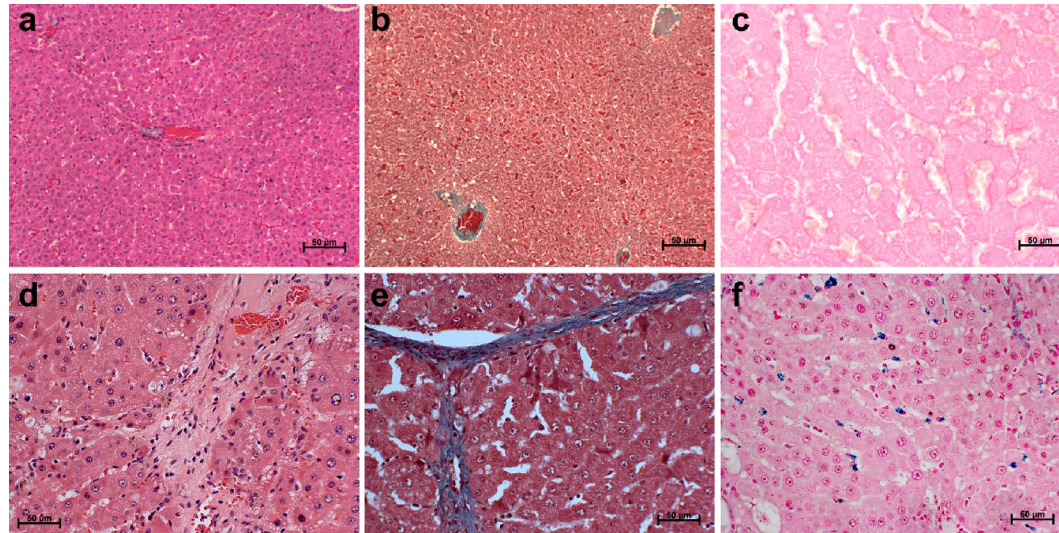
Figure 5. Histological evaluation of liver from normal and fibrosis model. H&E sections of ( a ) normal liver showing lobular architecture with central vein and radiating hepatic cords, ( d ) fibrosed liver showing disruption of the tissue architecture, pseudo-lobe separation with extension of fibres. MT staining of fibrosed liver ( e ) shows the presence of blue coloured fibrous accumulation that is not visible in normal liver section ( b ). Presence of iron in the P-SPION administered fibrosed liver ( f ) clearly visible in the PB stained sections whereas it is absent in the case of normal liver ( c